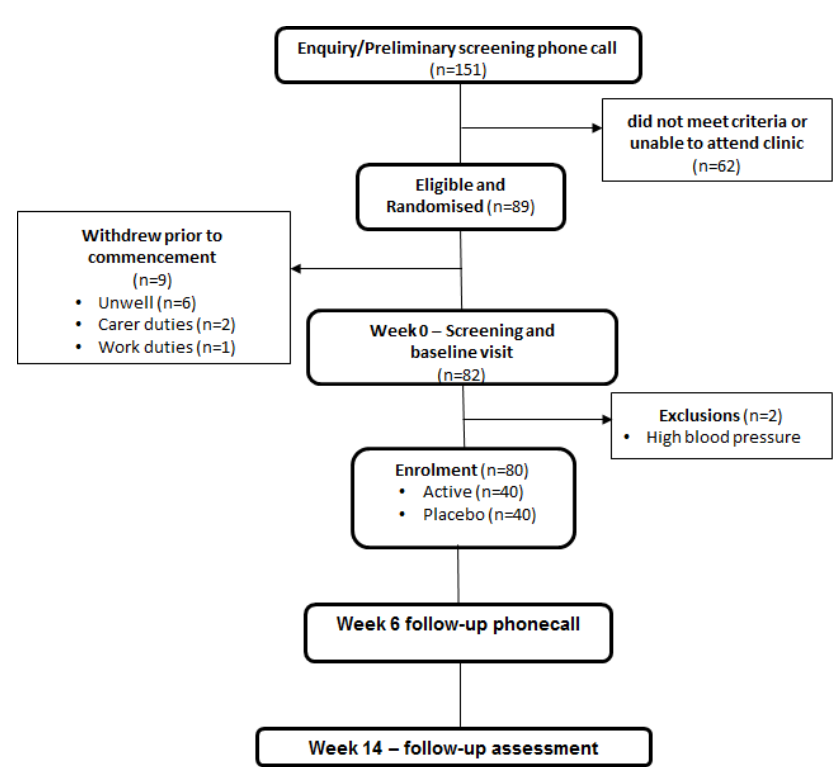
Figure 1. Consort diagram for study participants.